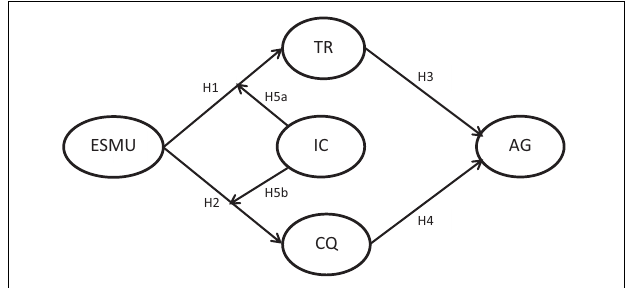
FIGURE 1 | Research